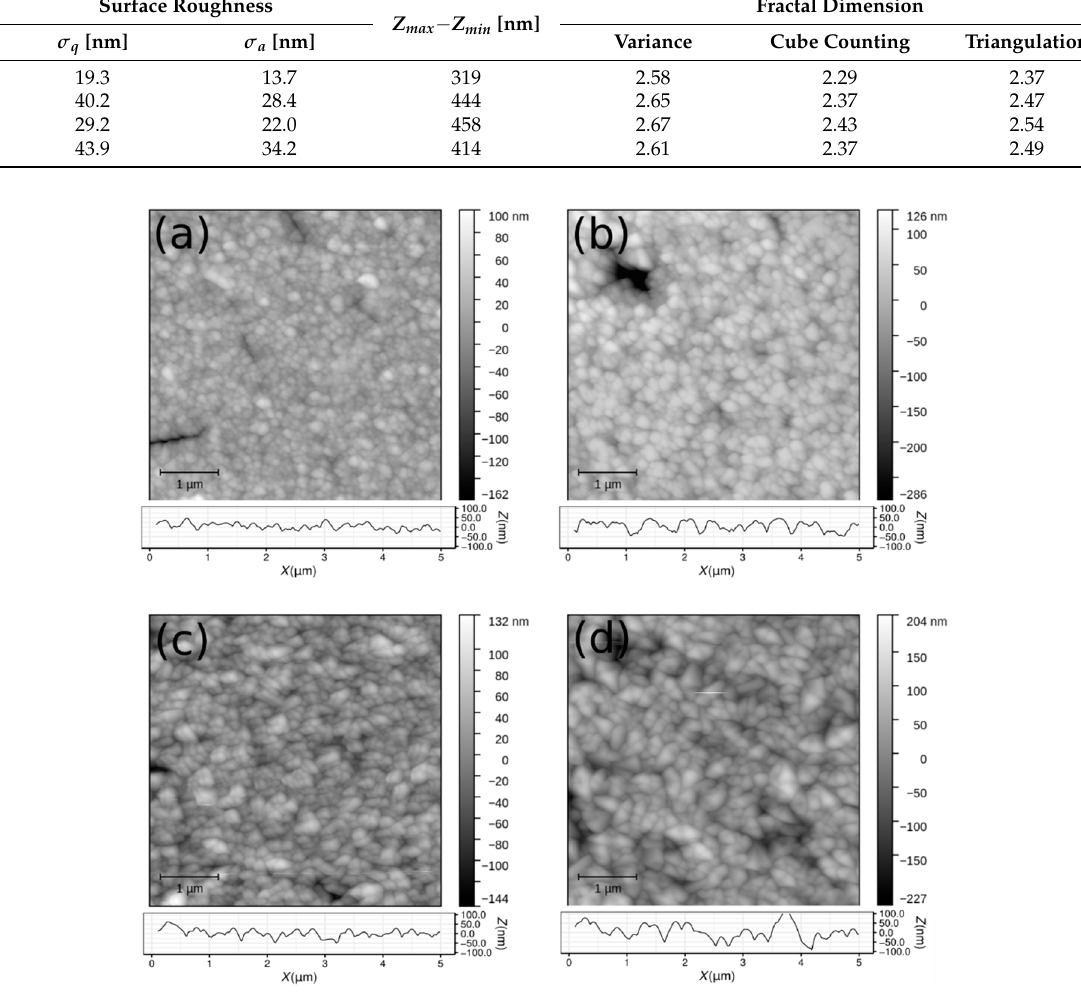
Figure 3. D AFM images of SnO 2 thin film samples surface: ( a ) S-610, ( b ) S-590, ( c ) B-610, ( d ) B-590. 1D horizontal profile is added below each 2D image.